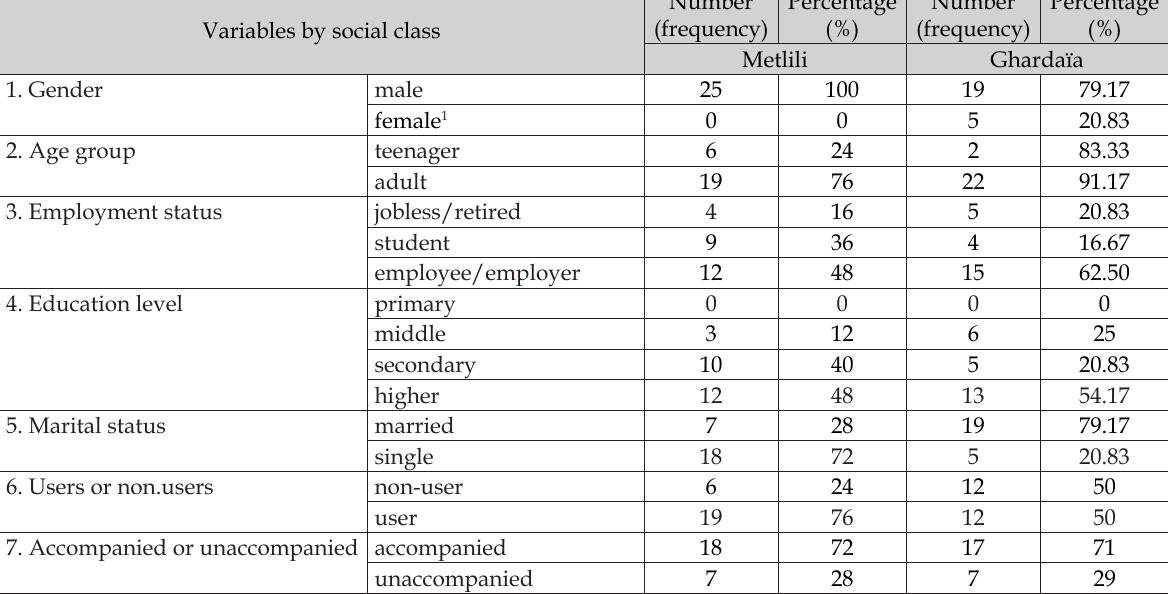
Table 1. Sociodemographic structure of the